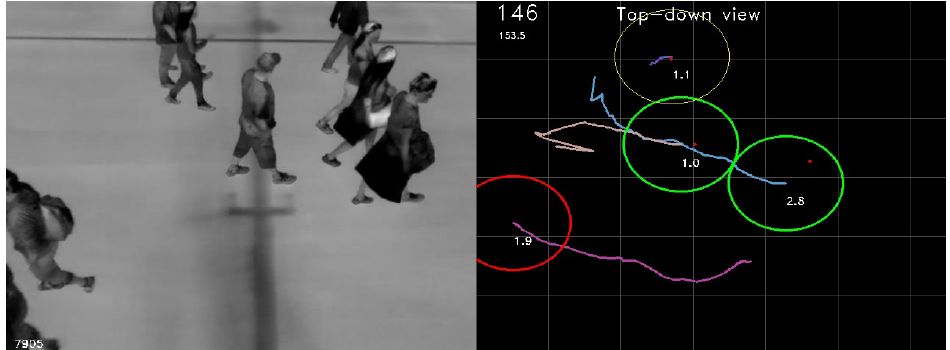
Figure 5. Example of the running system. The image on the left is the undistorted left input image; the image on the right is a top-down view of the street used to show the tracked groups. The number in the lower left corner of the left-hand image (7905) is the current frame number. The number in the top left corner of the right-hand image (146) is the current count of pedestrians that have walked by. The number just below that (153.5) is the current count without rounding. The center of mass of each detected group is shown with a small red dot. Each predicted state has a predicted number of group members shown as a small number (1.9, 1.1, 1.0, 2.8). The maximum allowed distance from the predicted positions is shown by circles in different colors and line thicknesses. Thin yellow means that the track is young and has a point in the current frame. Thin red (not shown in this case) is young and does not have a point. Thick green is a track that is old enough to be counted and has a point. Thick red is also old enough to be counted but does not have a point in the current